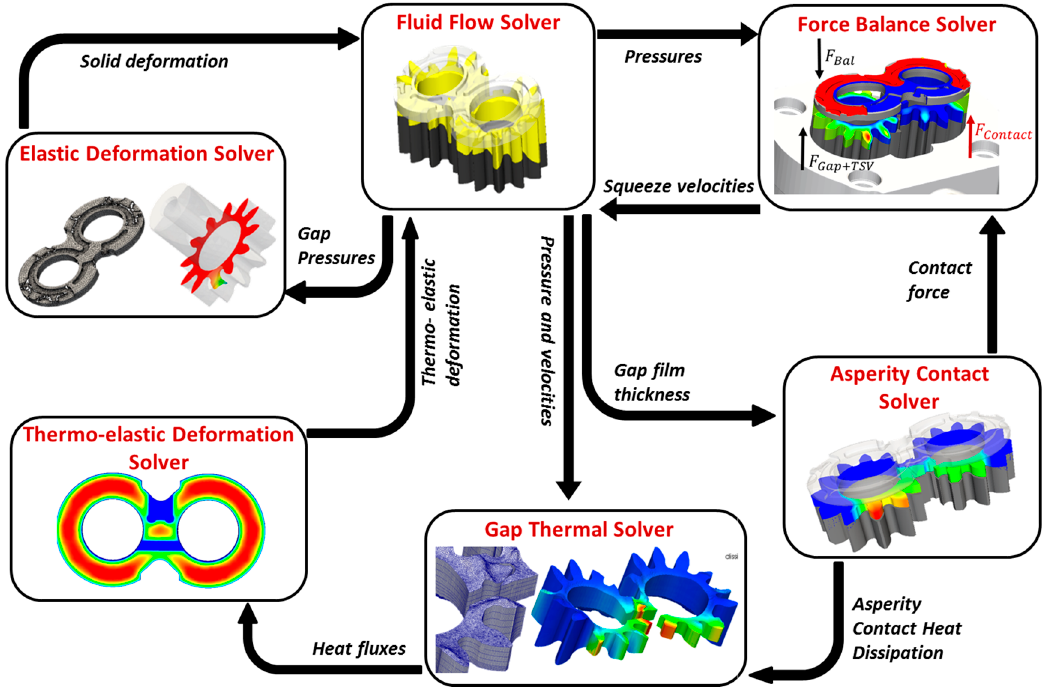
Figure 3. Interaction between the different sub-models constituting the mixed-TEHD lateral lubricating gap model for the EGMs.